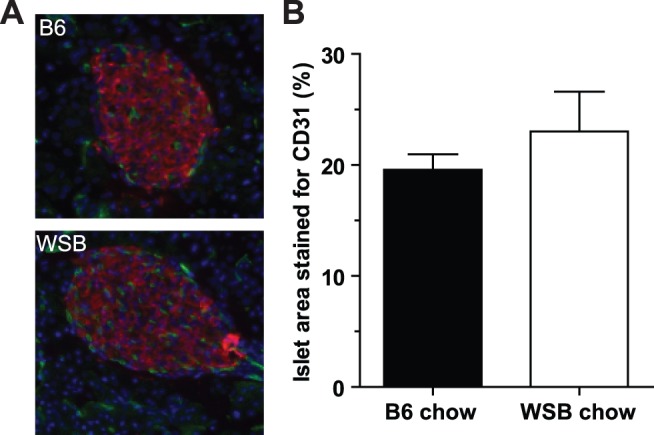
Islet vascularization at 4 weeks of age.A. Islet vascularization of chow-fed C57BL/6J (top) and WSB/EiJ (bottom) mice. Vasculature (CD31) is stained in green, while insulin is stained red to demarcate islet areas. B. Percent of islet area stained for CD31. (n = 5 per strain).